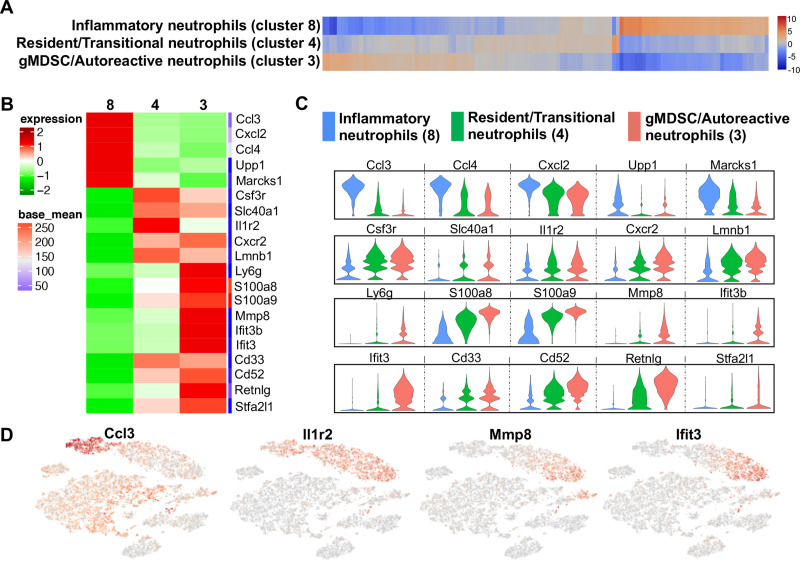
Neutrophil populations segregated by unsupervised clustering relate to cell-programming among treatment groups.(A) Heatmap shows the top 120/N upregulated genes for 3 distinct neutrophil clusters ranked by log2 fold-change, where N = total number of clusters. (B) Top 5–10 genes of the three neutrophil clusters plotted in heatmap to show differences and gene names in transcript levels. (C) Violin plots show expression with population distribution among inflammatory neutrophils, represented by blue (cluster 8), resident/transitional neutrophils, represented by green (cluster 4) and granulocytic myeloid-derived suppressor cells (gMDSC)/autoreactive neutrophils, represented by red (cluster 3). The y-axis indicates normalized expression value, log2 (average UMI count + 1). (D) Representative gene from each neutrophil cluster showing their distribution in t-SNE.